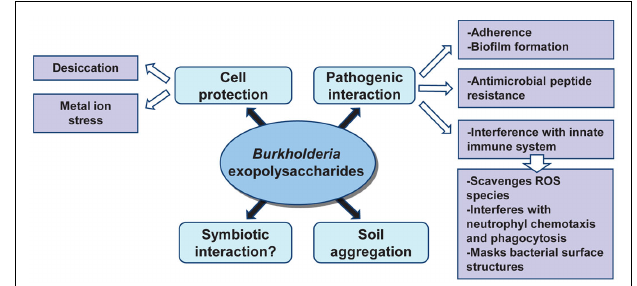
FIGURE 3 | Roles of Burkholderia exopolysaccharides in the adaptation to different